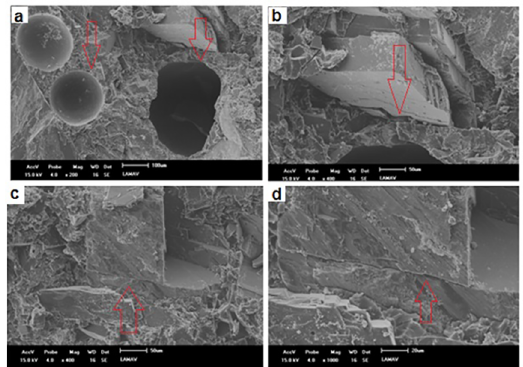
Figure 4. Scanning electron micrograph of the fracture region of the artificial marble with 60% wt/wt of residue without vacuum action and compaction with increases of 200x (a), 400x (b), 400x (c), 1000x (d) and 2000x